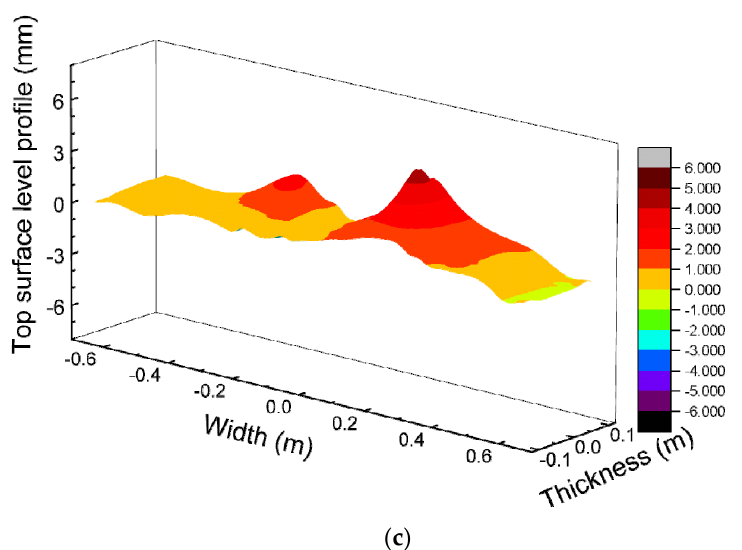
Figure 7. Top surface-level profile with different widths under low steel throughput: ( a ) 880 mm, ( b ) 1050 mm, and ( c ) 1300 mm.